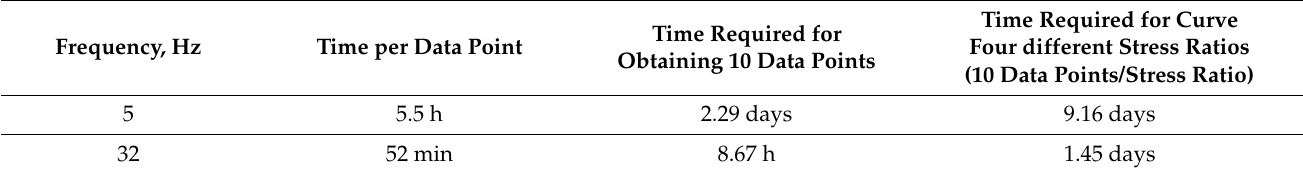
Table 4. Costs associated with testing at different